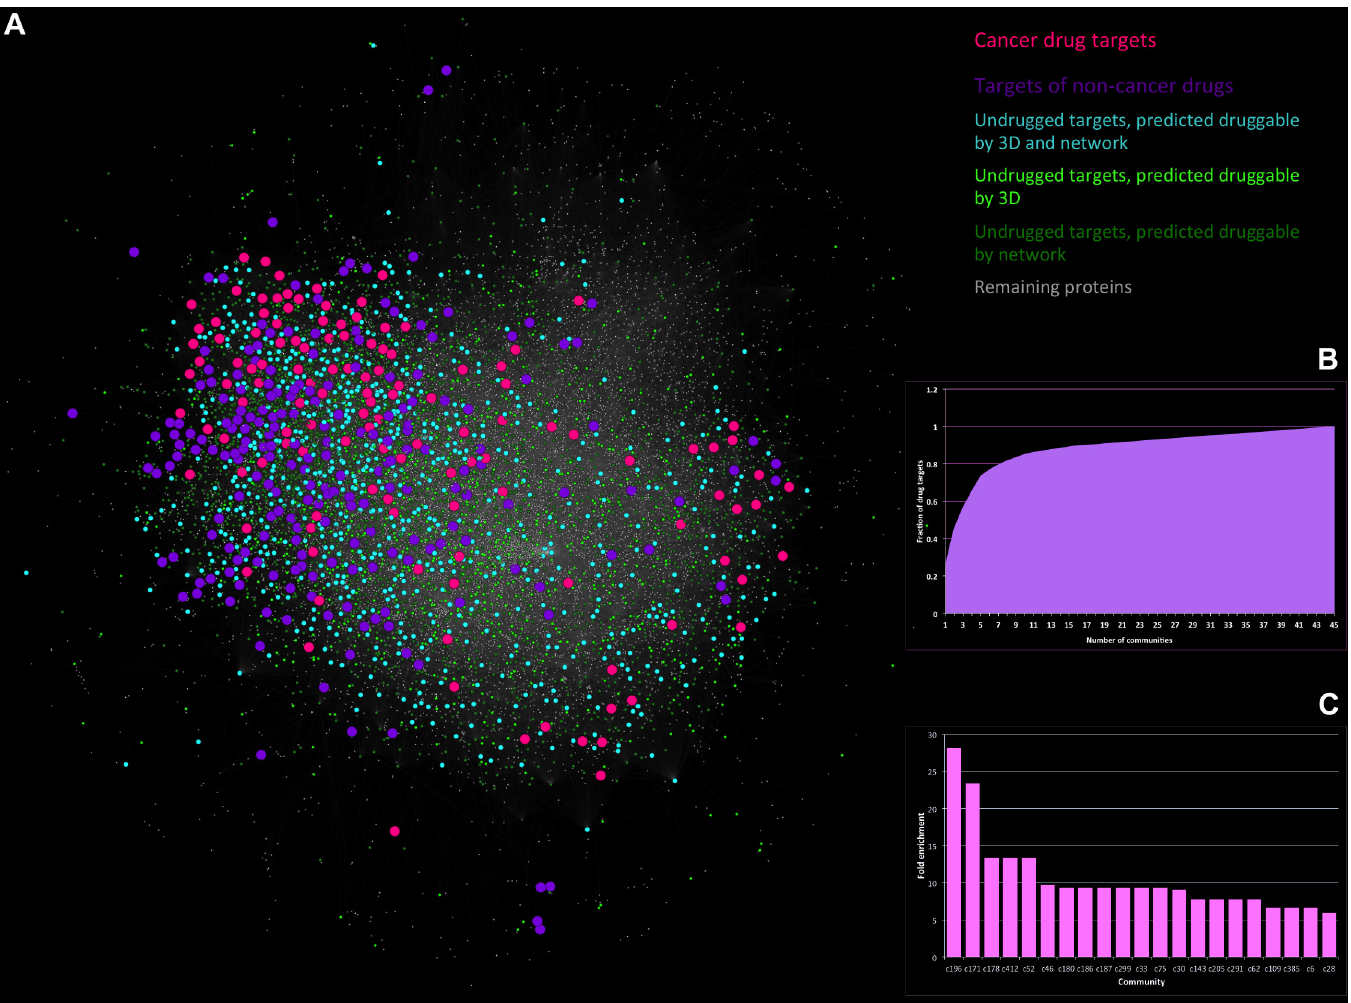
Fig 2. Cancer-drug targets are enriched for highly connected Graphlets. A) Interaction network highlighting the distribution of targets of approved cancer drugs (pink); targets of approved drugs from non-cancer therapeutic areas (blue); and targets predicted to be druggable by different druggability prediction methodologies(light and dark green). Druggable proteins are spread widely across the network while targets of current approved drugs tend to cluster into few areas. B) Cumulative fraction of all drug targets covered by communities. As indicated, a small number of communities cover the majority of drug targets. C) The network communities most enriched in drug targets are listed against the fold enrichment of the number of targets found in them (compared to what can be expected at